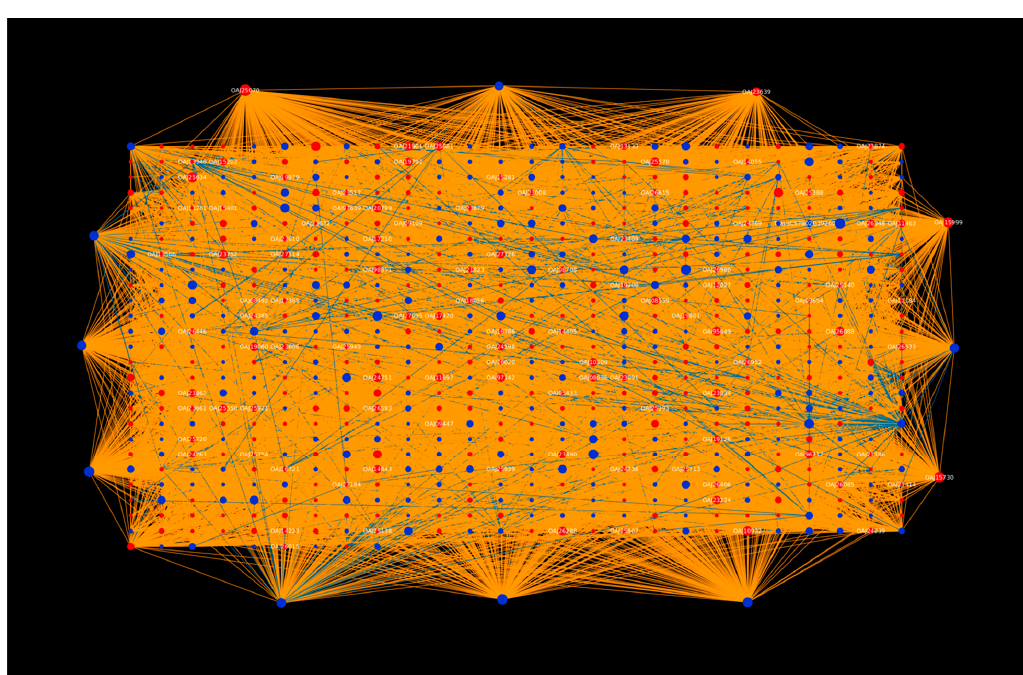
Figure 5. Visualization of the top GO term (GO:0009526, plastid envelope) from the cellular component category. Blue nodes represent host proteins, red nodes are pathogen proteins. Orange edges depict the interactions from the interolog-based approach, while blue edges belong to the domain-based approach.